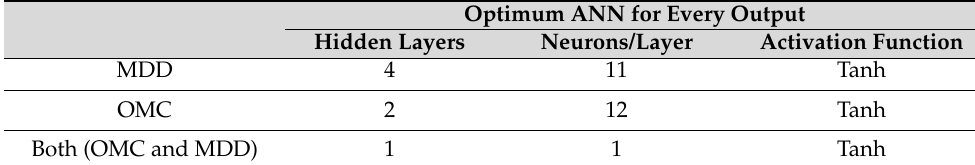
Table 12. The optimum ANN for every